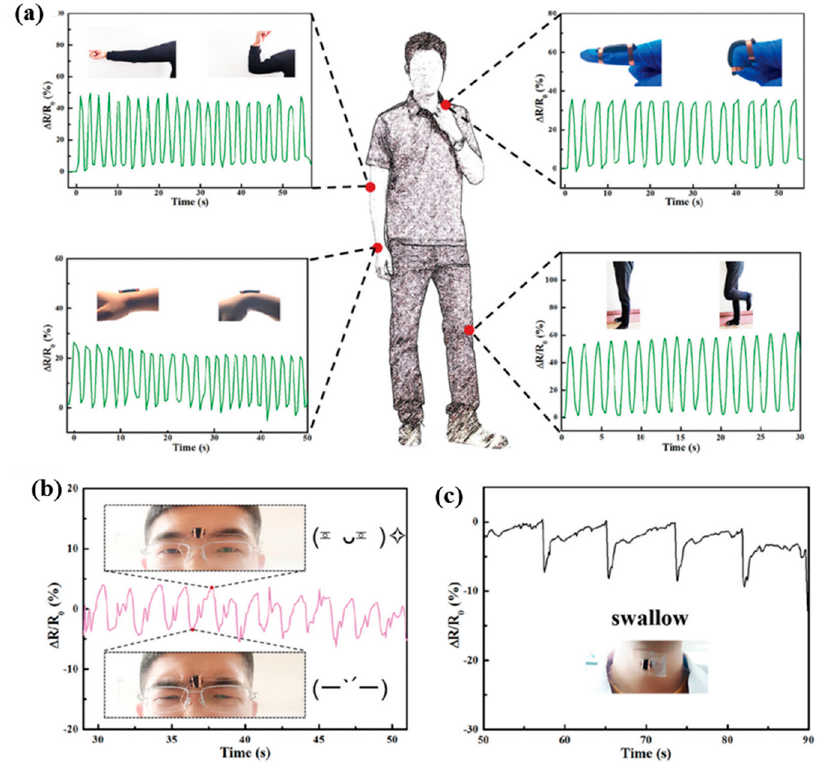
Figure 10. ( a ) PNIPAM-ECH for large-scale human motion detection (elbow motion, finger bending, wrist bending, and knee motion). ( b ) PNIPAM-ECH for facial expression detection. ( c ) PNIPAM-ECH for swallow motion detection. Copyright from Ref. [75] Royal Society of